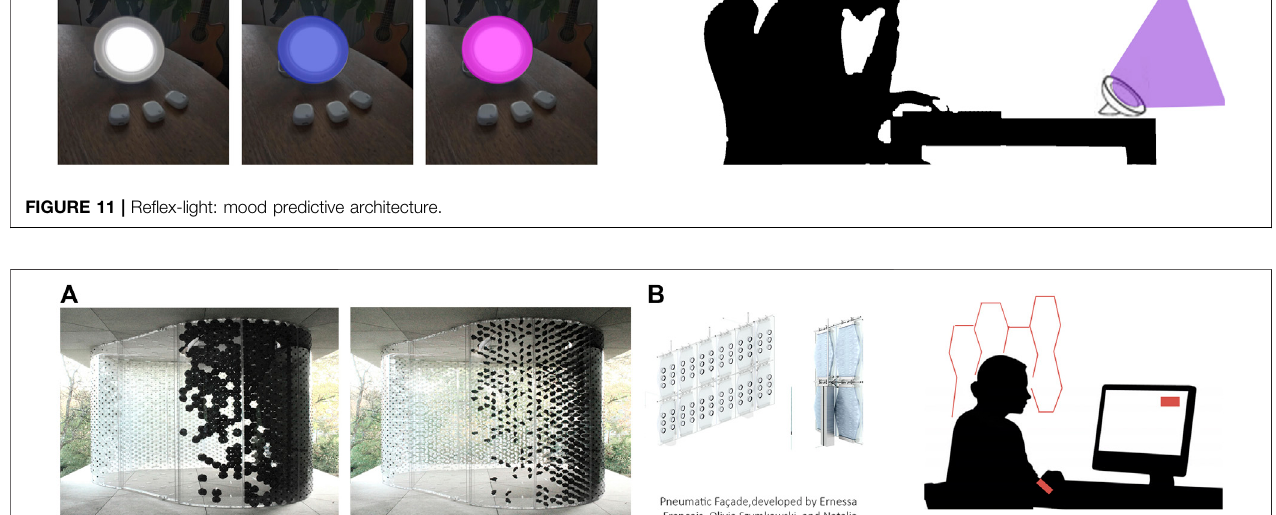
FIGURE 12 | Air fl ow: bio-design for air quality. Image source for (A) : Tobias Becker ’ s Breathing Skins Project (https://www.archdaily.com/789230/let-your- building-to-breathe-with-this-pneumatic-facade-technology). Image source for (B) : Pneumatic Façade: The project was developed by Ernessa Francois, Olivia Szymkowski, and Natalia Wilk, NJIT ’ 19 for the Adaptive and Autonomous Environments Options Studio III, advised by professor Andrzej Zarzycki, NJIT (http://andrzejzarzycki.com/pneumatic-facade/).